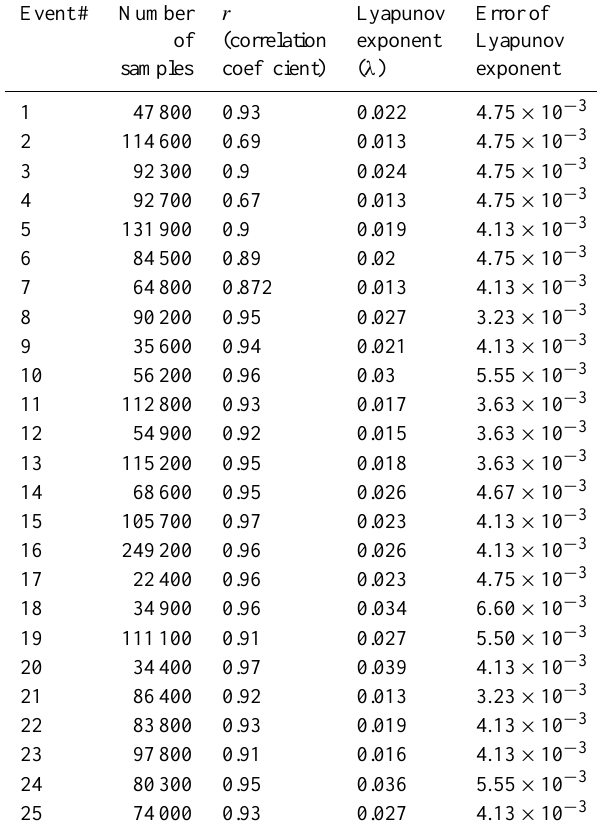
Table 2. Summary of the results of the estimation of maximal Lya- punov exponent. The correlation coefficient r refers to the linear part of the stretching factor curve.